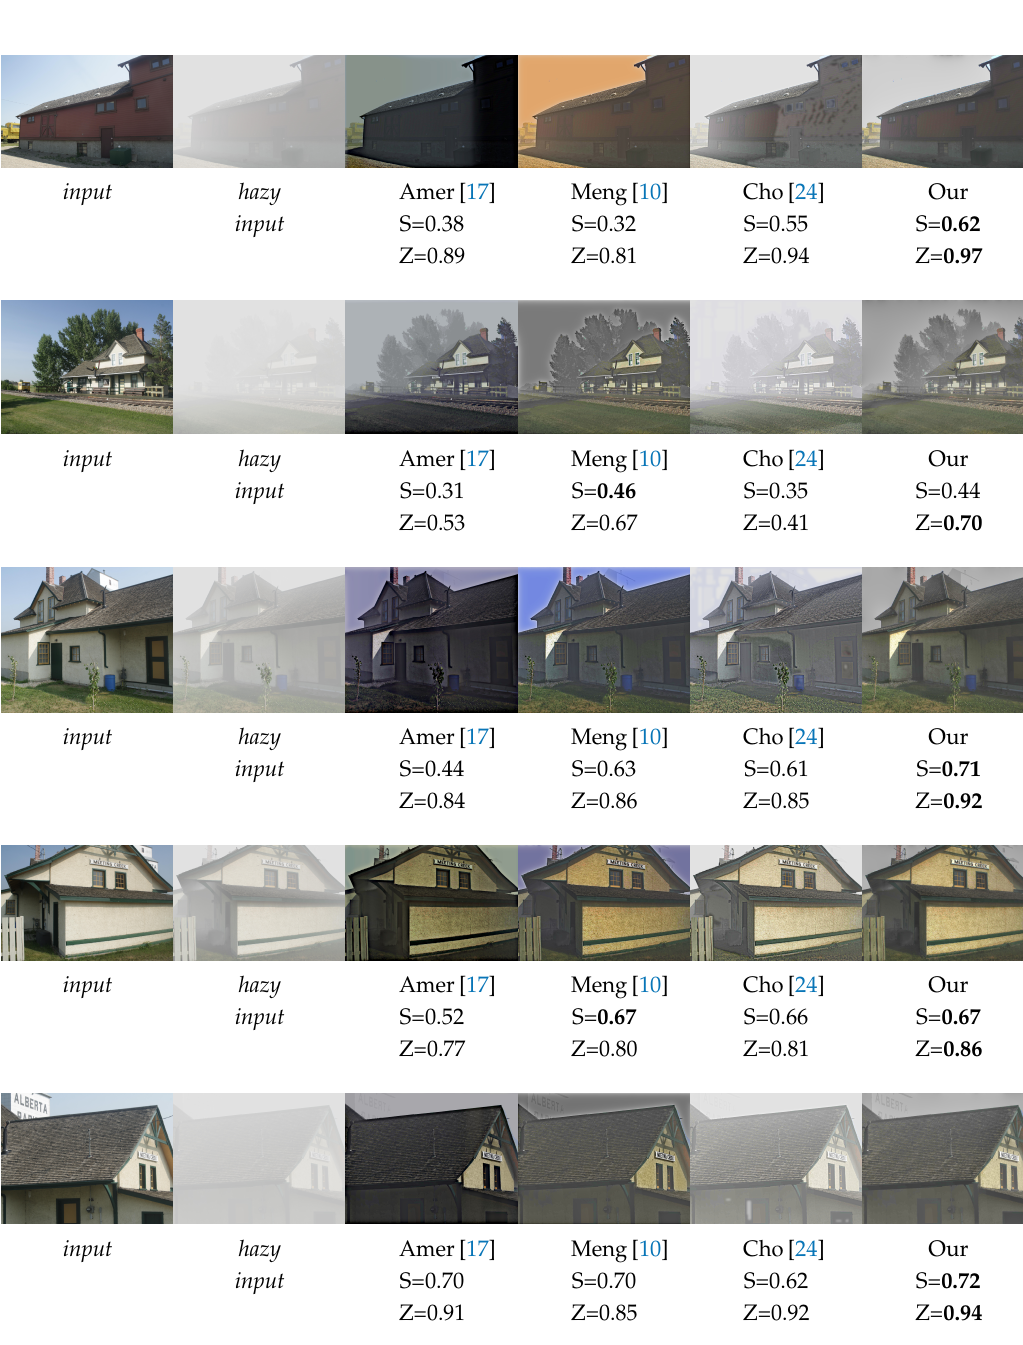
Figure 8. Comparison between five images with their SSIM (S) and ZNCC (Z) scores. In bold the best results for each